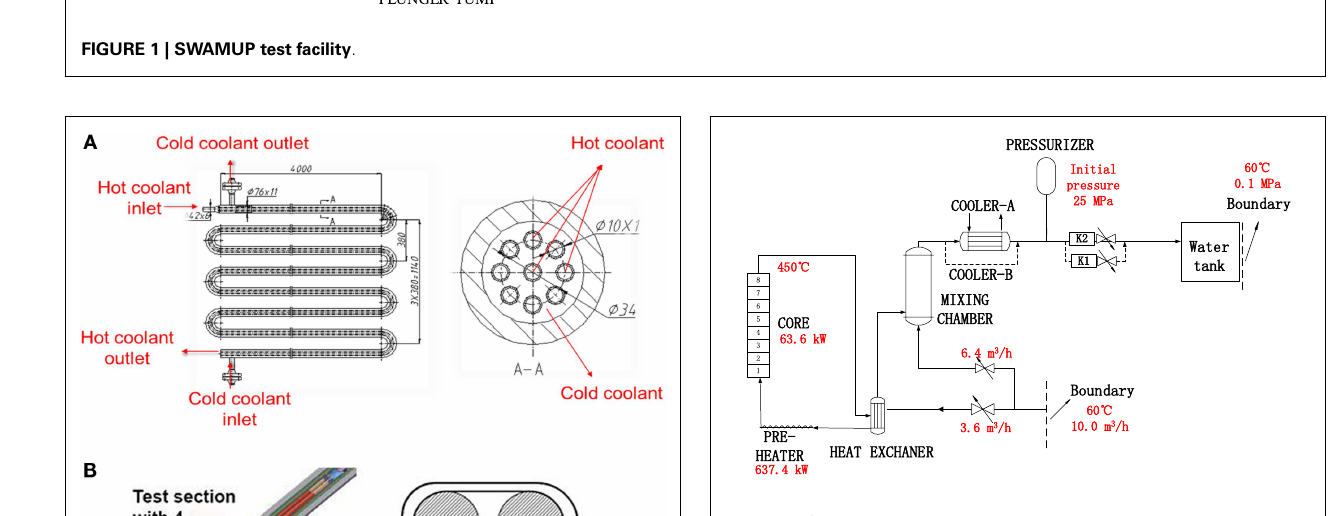
FIGURE 3 | Model of SWAMUP test facility